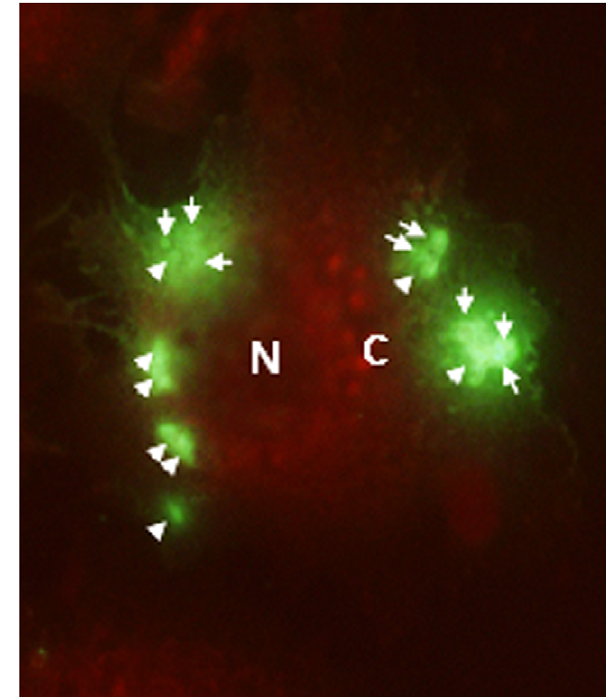
Figure 2. In-vitro development of liver stage parasites. 25,000 Pv spz was used to infect 20,000 HepG2-A16 cells. Uninfected spz were washed off after three hrs and cells were maintained for 3 days with daily media change. Cells were fixed and Pv liver stage trophozoites (400 X magnification) were stained with mAb NVS3 against the PvCSP (20 m g/ml). N : Nucleus of HepG2-A16 cells, C : Cytoplasm of HepG2-A16 cells, P : Developing 3 day old Pv hepatocyte stage parasite (trophozoite).